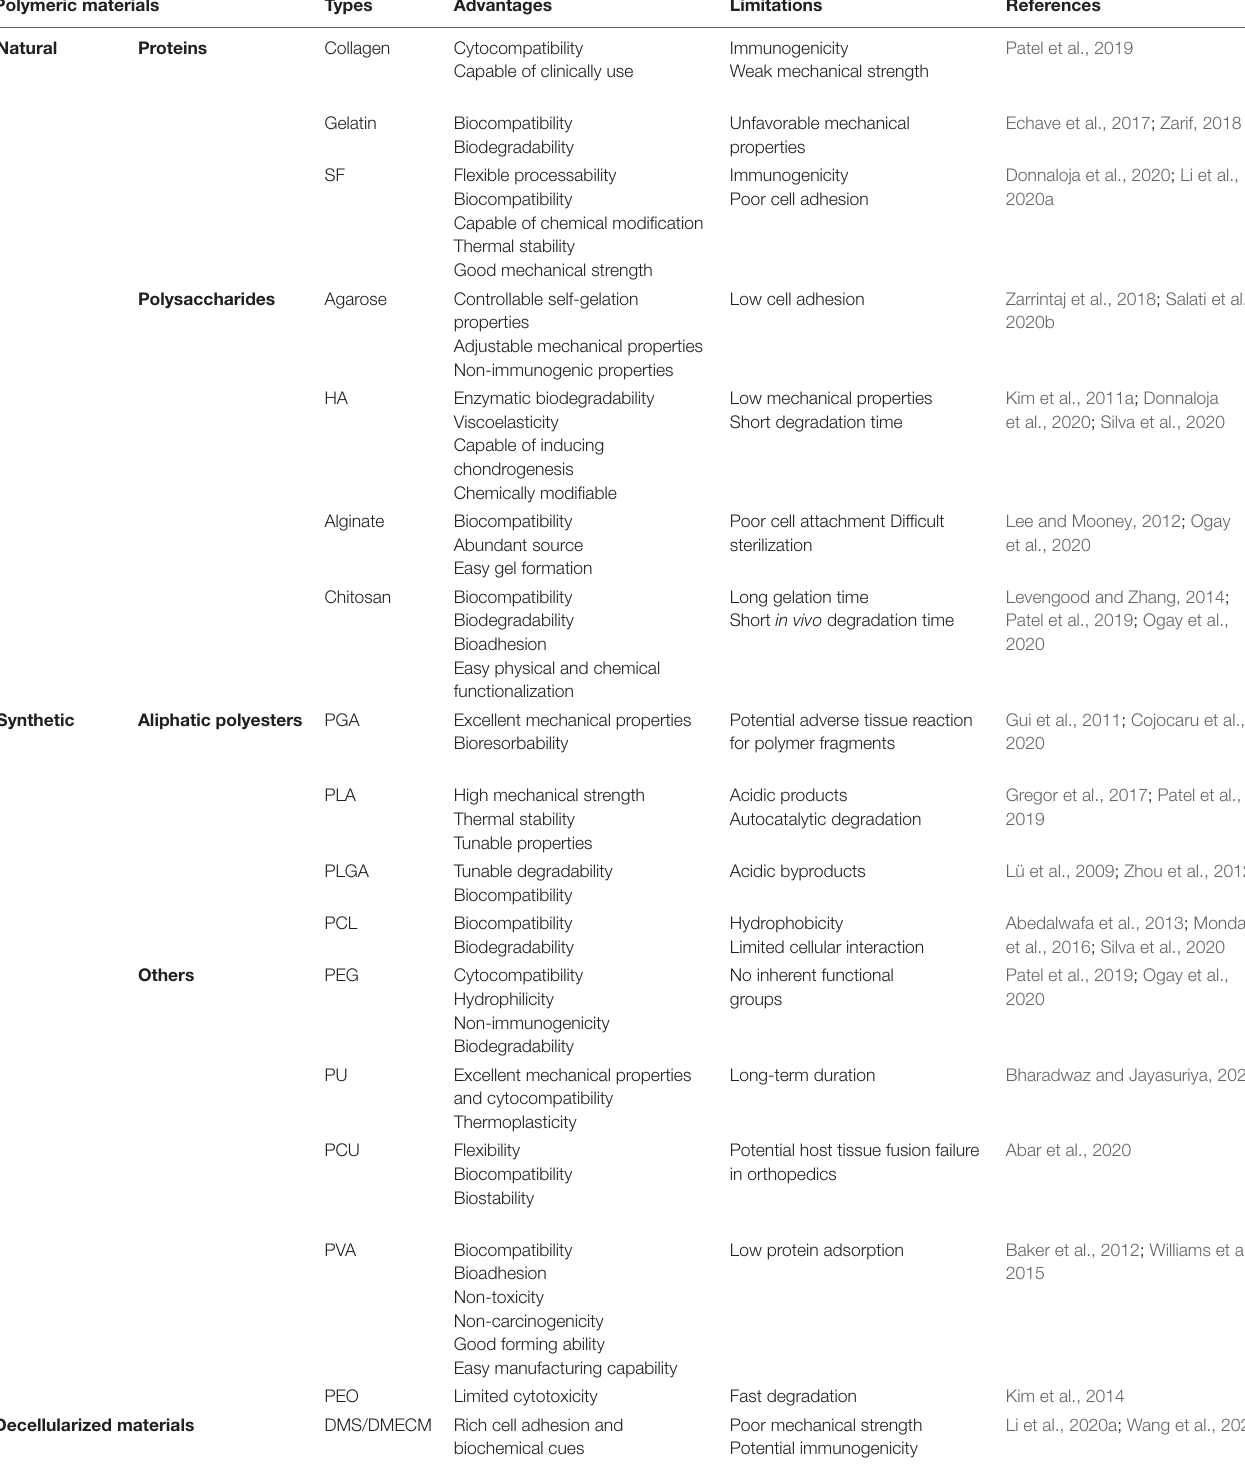
TABLE 3 | Most relevant natural and synthetic polymer types used in meniscal tissue